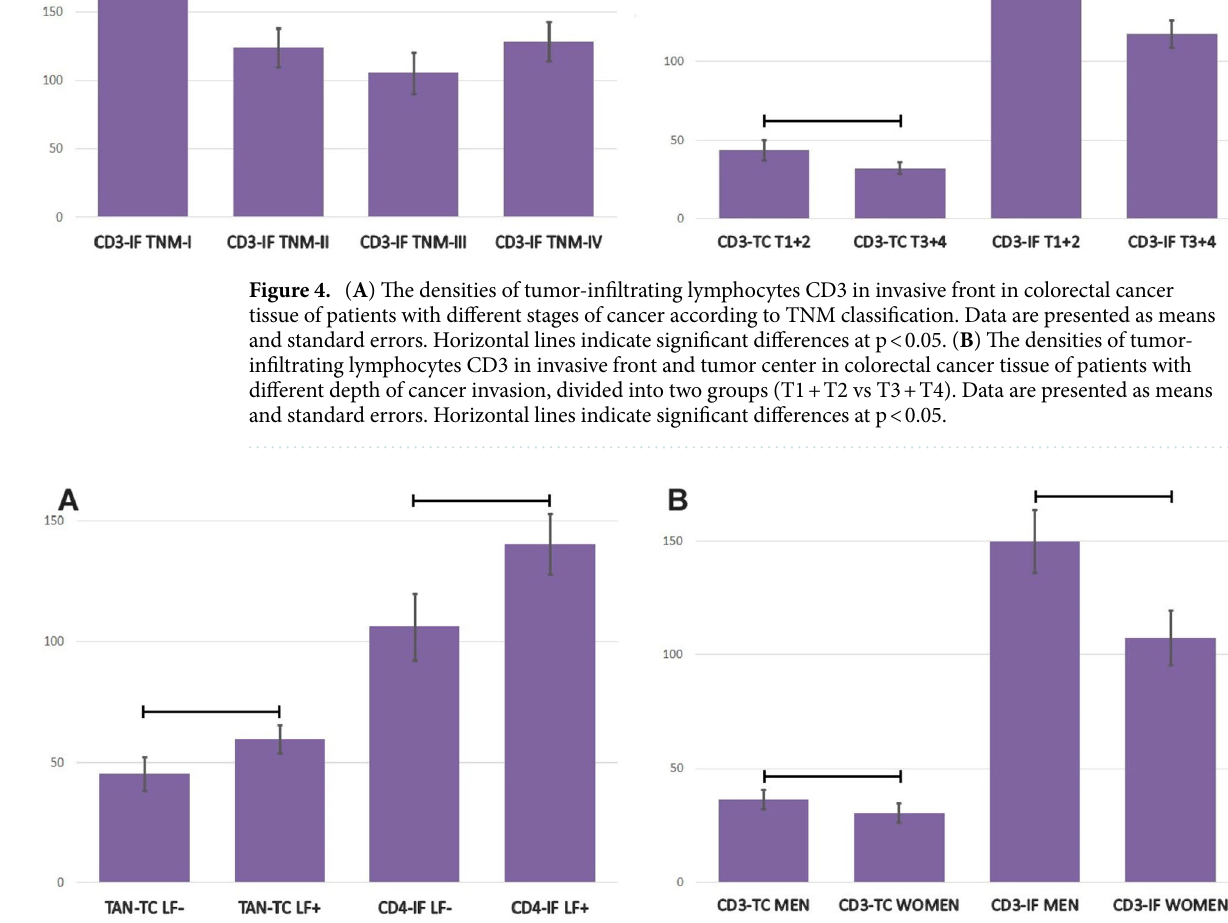
Figure 5. ( A ) The densities of tumor-infiltrating lymphocytes CD4 in invasive front and tumor-associated neutrophils (TAN) in tumor center in colorectal cancer tissue of patients with lymphoid follicles (LF+) and without lymphoid follicles (LF−). Data are presented as means and standard errors. Horizontal lines indicate significant differences at p < 0.05. ( B ) The densities of tumor-infiltrating lymphocytes CD3 in tumor center and invasive front in colorectal cancer tissue of male and female patients. Data are presented as means and standard errors. Horizontal lines indicate significant differences at p <